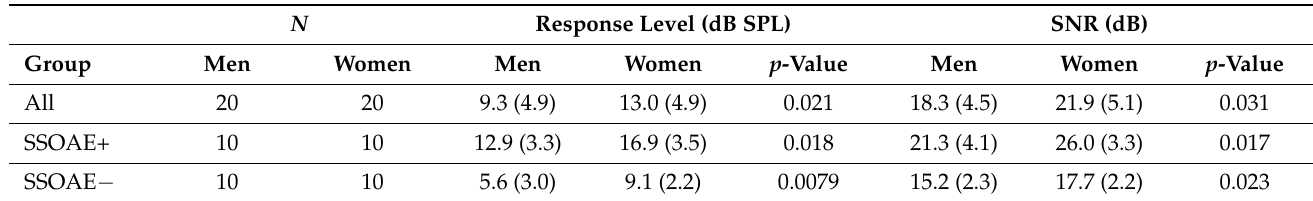
Table 1. Average global response levels and SNRs of TEOAEs of studied groups of men and women together with standard deviations (in brackets). Additionally, p -values for comparisons between subgroups of men and women are shown. The data are divided according to SSOAE